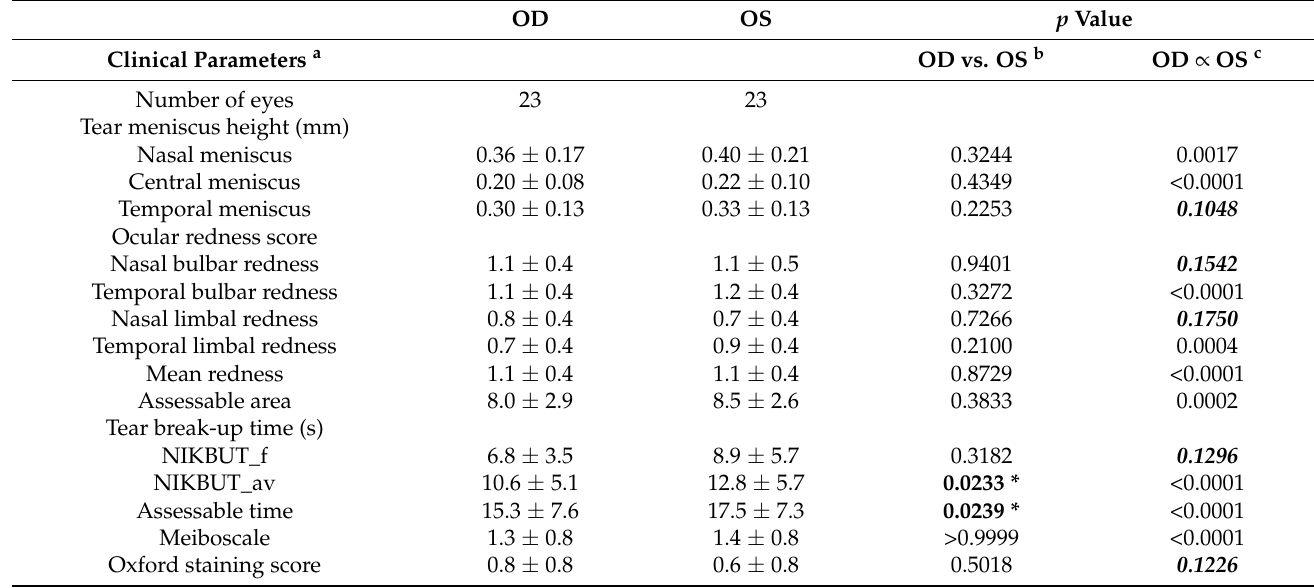
Table 1. Binocular clinical performance of dry eye patients.